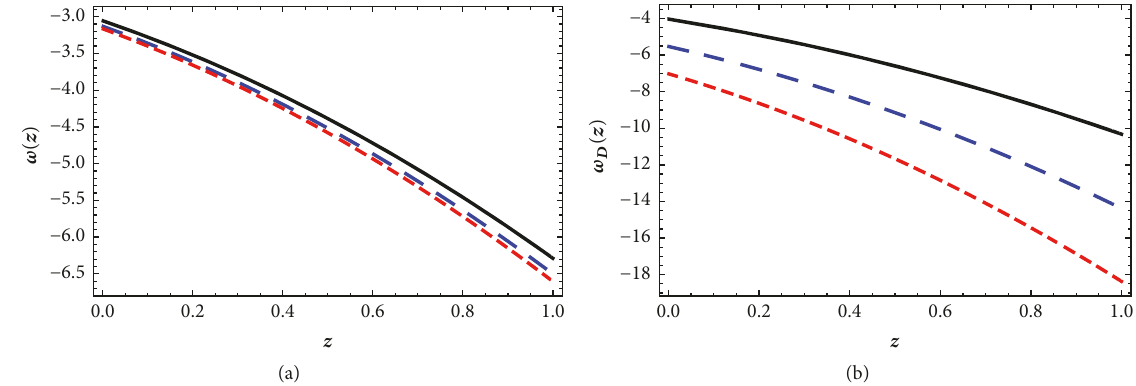
Figure 3: Evolution of EoS as function of red-shift 𝑧 for 𝛼 = 0.8502 and 𝛽 = 0.4817 , (a) noninteracting and (b) interacting